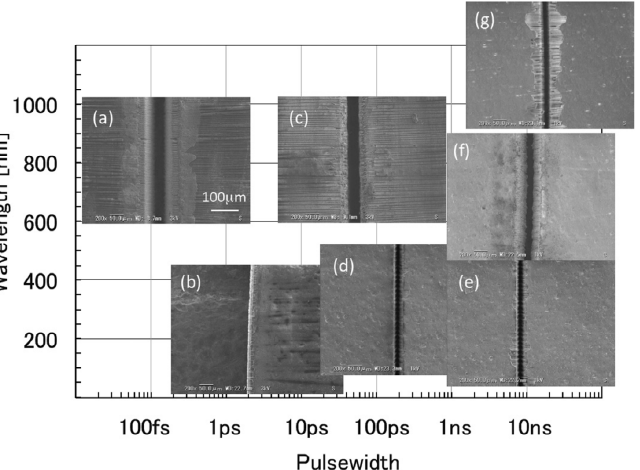
Figure 10. Processing morphology with different wavelengths and pulse widths, ( a ) the pulse width and wavelength of the laser beam of-( g ) are respectively: ( a ) 180 fs, 800 nm; ( b ) 35 ps, 800 nm; ( c ) 200 ps, 800 nm; ( d ) 2 ns, 355 nm; ( e ) 10 ns, 355 nm; ( f ) 10 ns, 532 nm; ( g ) 20 ns, 1064 nm [68].